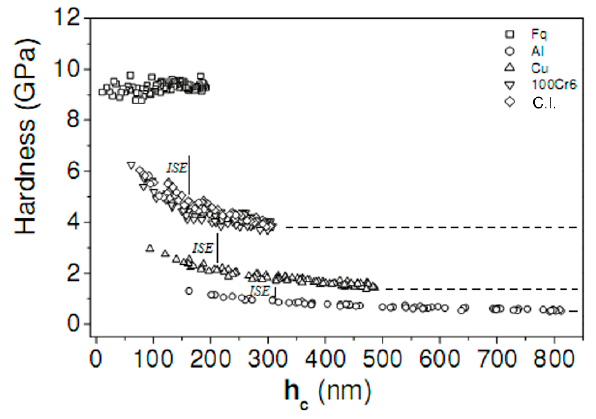
Figure 6. Influence of the penetration depth, h c , on the hardness of the five different materials. The threshold value beyond which the ISE no longer has effect is shown in the figure; as expected, this did not hold for the reference Fq.